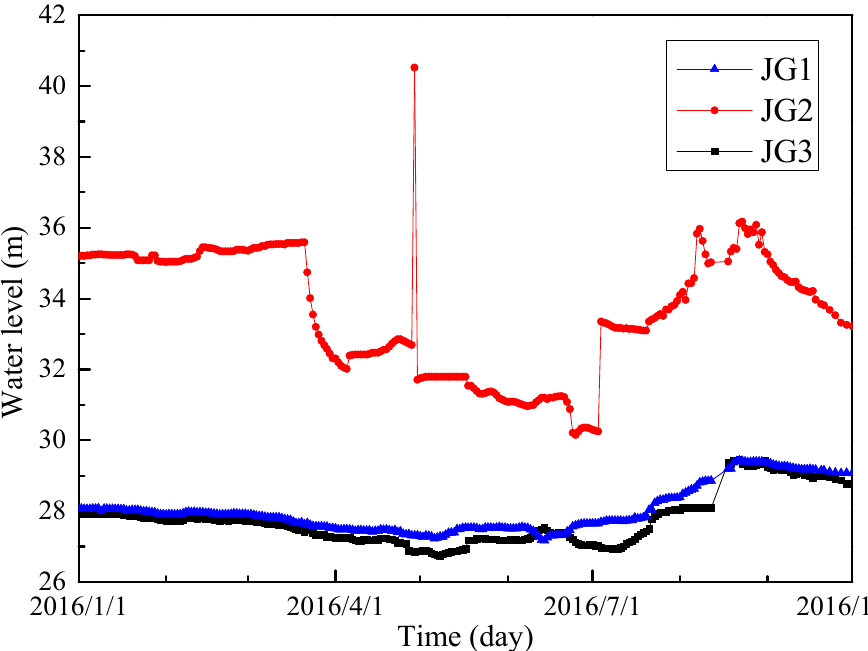
Figure 5. Water level of Sprouting Spring monitored in 2016.